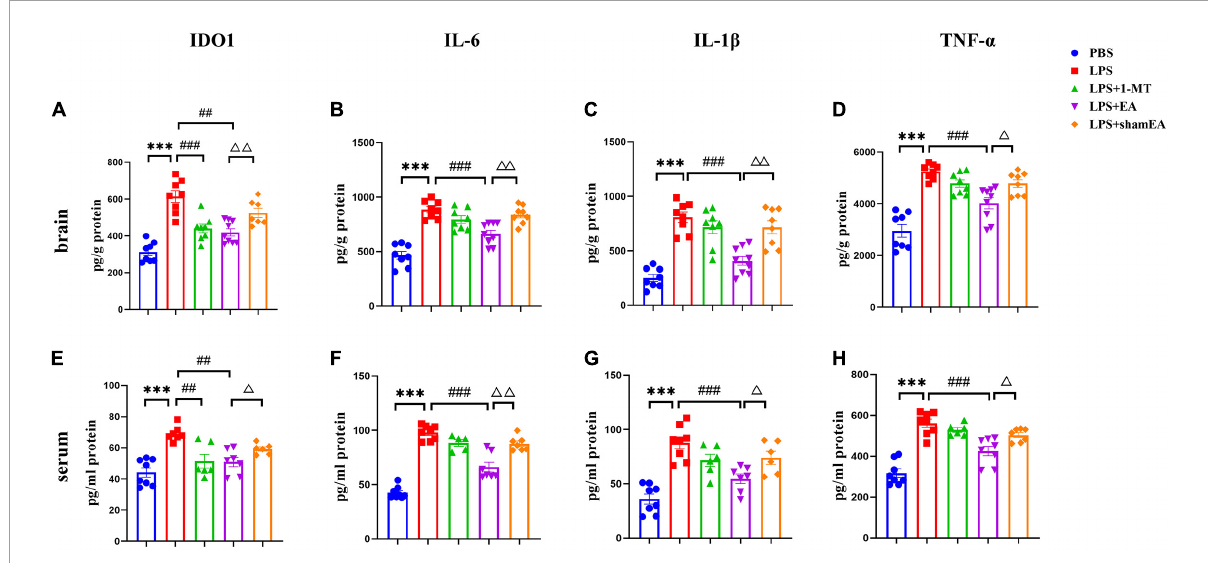
FIGURE3 Electroacupuncture reduced the level of IDO1, IL-6, IL-1 β , and TNF α in the brain tissue and serum, which were induced by LPS of mice. After being killed, the tissue and serum of mice were collected and analyzed for protein level in the peripheral (A–D) and center (E–H) of (A,E) IDO1,